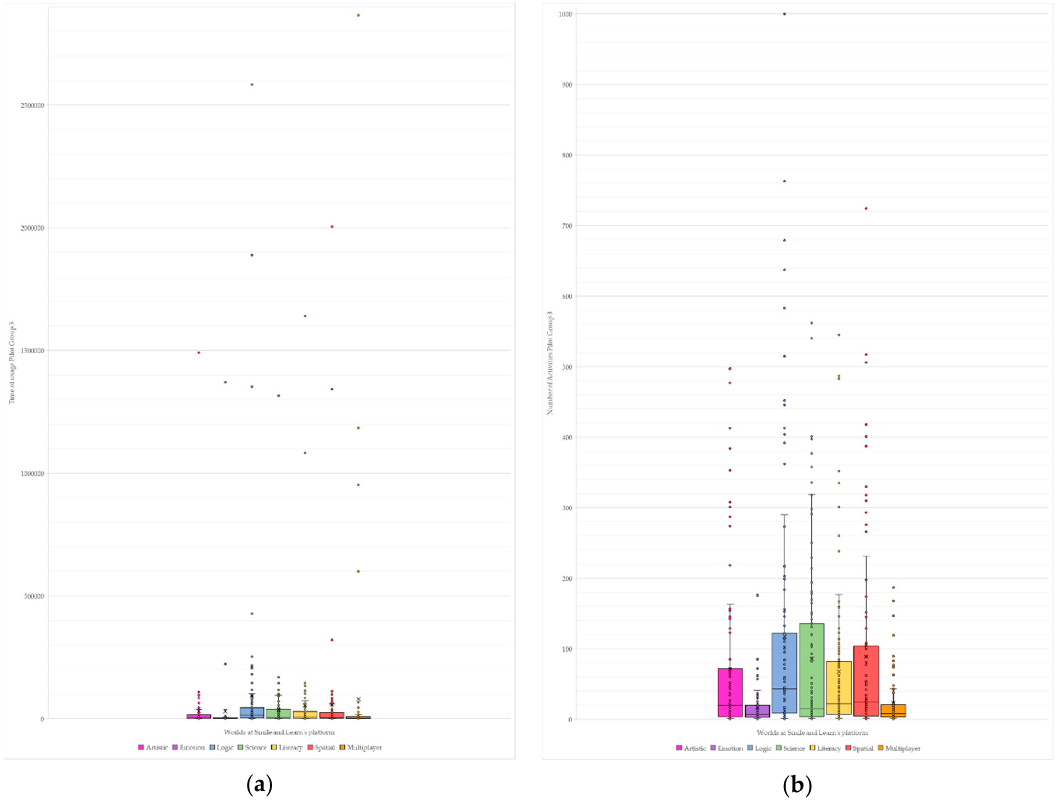
Figure 8. Pilot Group 2’s use of worlds (Arts, Emotion, Logic, Science, Literacy, Spatial, Multiplayer) at Smile and Learn’s platform. ( a ) General time of usage (seconds) with the platform for Pilot Group 3; ( b ) General number of activities played by Pilot Group 3 with the